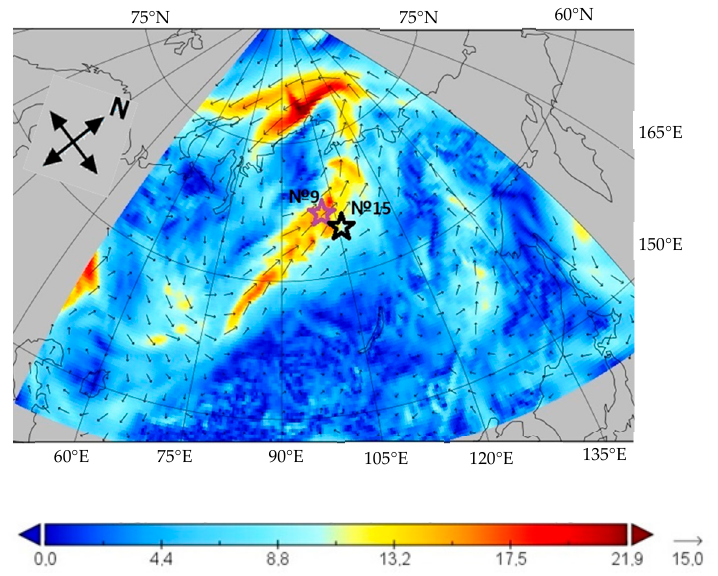
Figure 7. Wind speed and direction at the surface of 850 hPa according to ERA5 reanalysis data and location of fires No. 9 and No. 15.